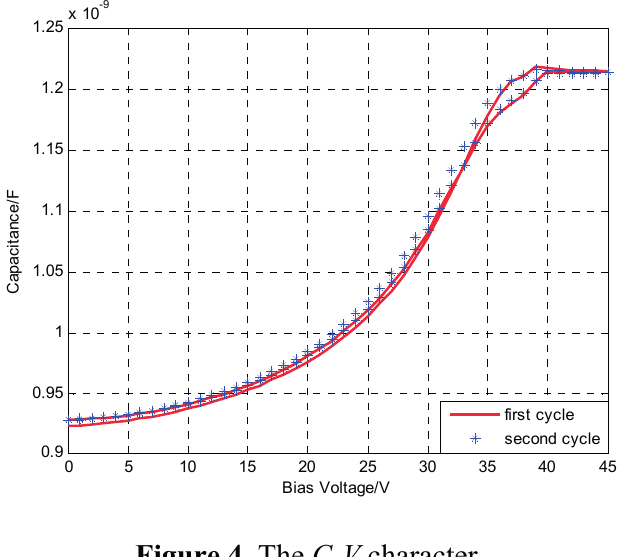
Figure 4. The C-V